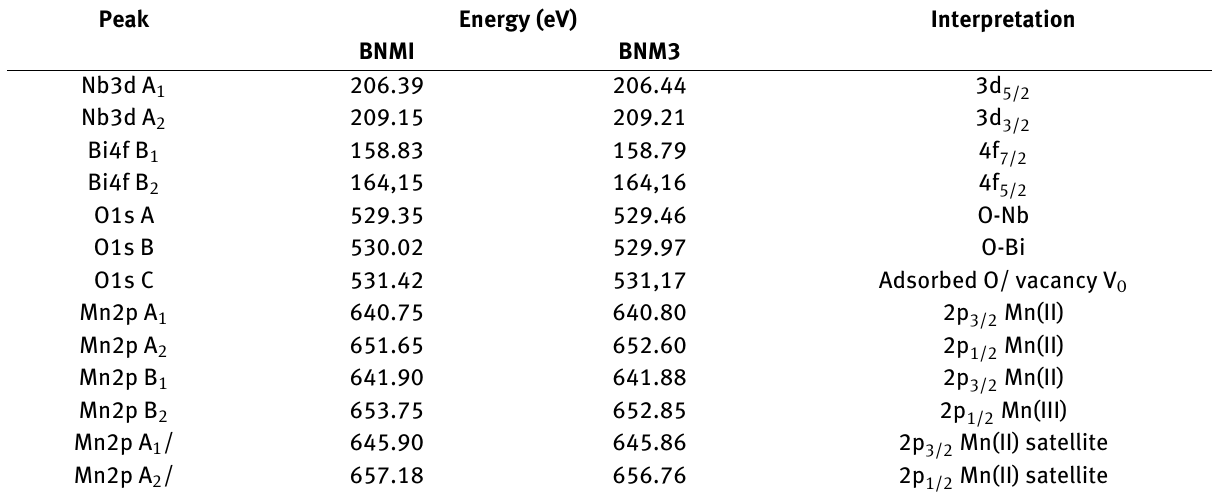
Table 1: The energy positions of components of the XPS spectra. Peak Energy